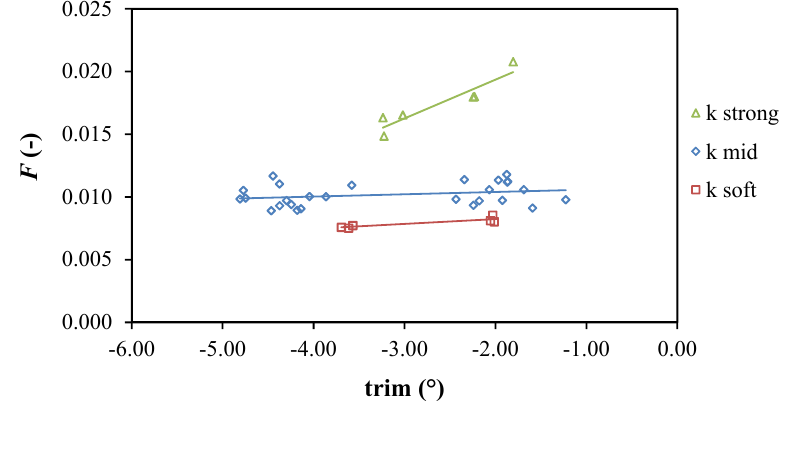
Figure 7. Correlation between non-dimensional extreme mooring forces and mean pitch, or trim.